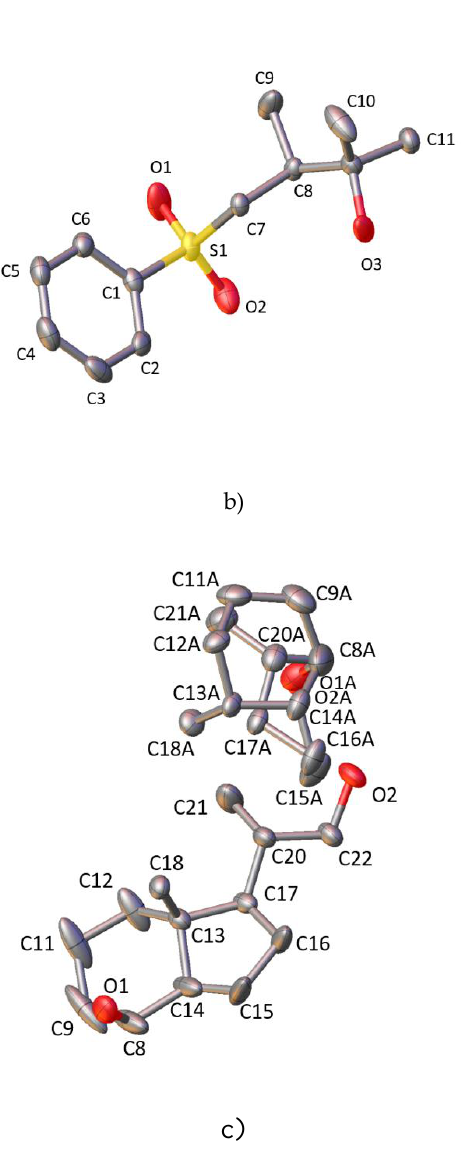
Figure 2. Displacement ellipsoid plot (50% probability level) of ( a ) 1 , ( b ) 2 , and ( c ) 3 . The hydrogen atoms were omitted for clarity.